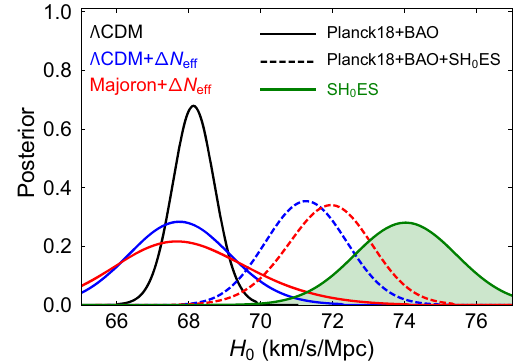
Fig. 2 H 0 posteriors for (cid:7) CDM (black), (cid:7) CDM + (cid:5) N eff (blue), and majoron + (cid:5) N eff (red), using Planck2018 + BAO (solid) and includ- ing a gaussian likelihood for SH 0 ES (dashed). SH 0 ES posterior shown for comparison in green. See Table 1 for best-fit values and 1 σ uncer- tainties. The red solid line roughly corresponds to H 0 = 68 . 0 ± 1 .